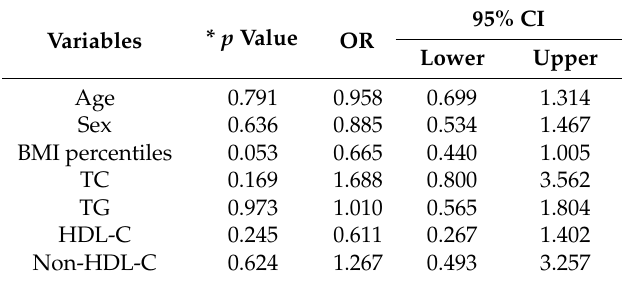
Table 2. Association of 25(OH)D deficiency with other